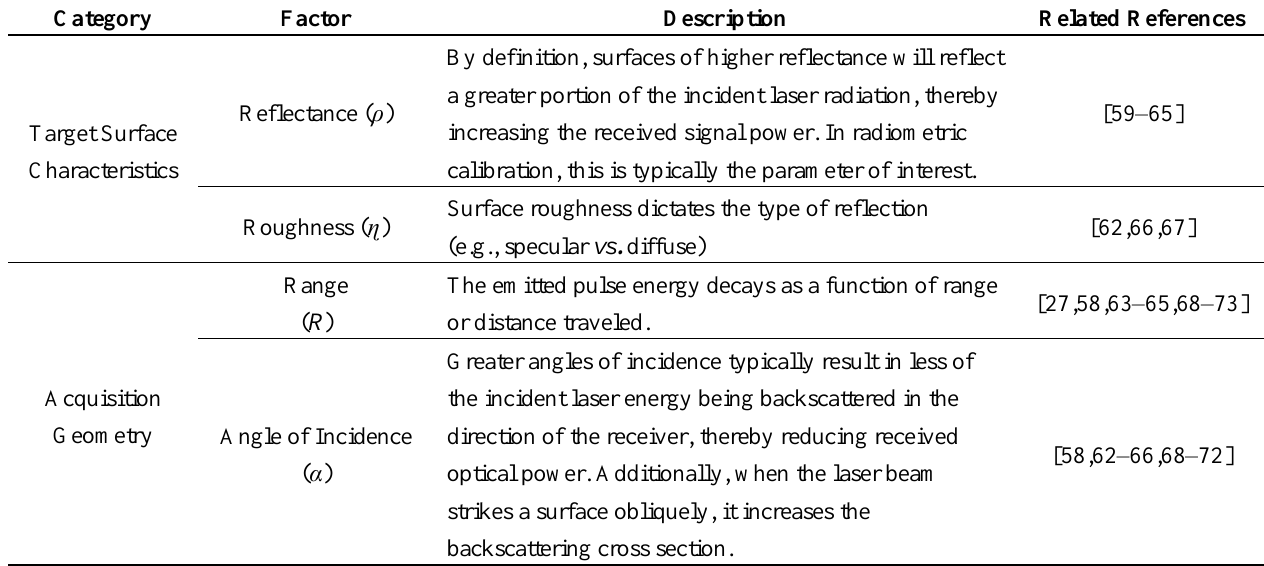
Table 2. Effective factors influencing LIDAR intensity